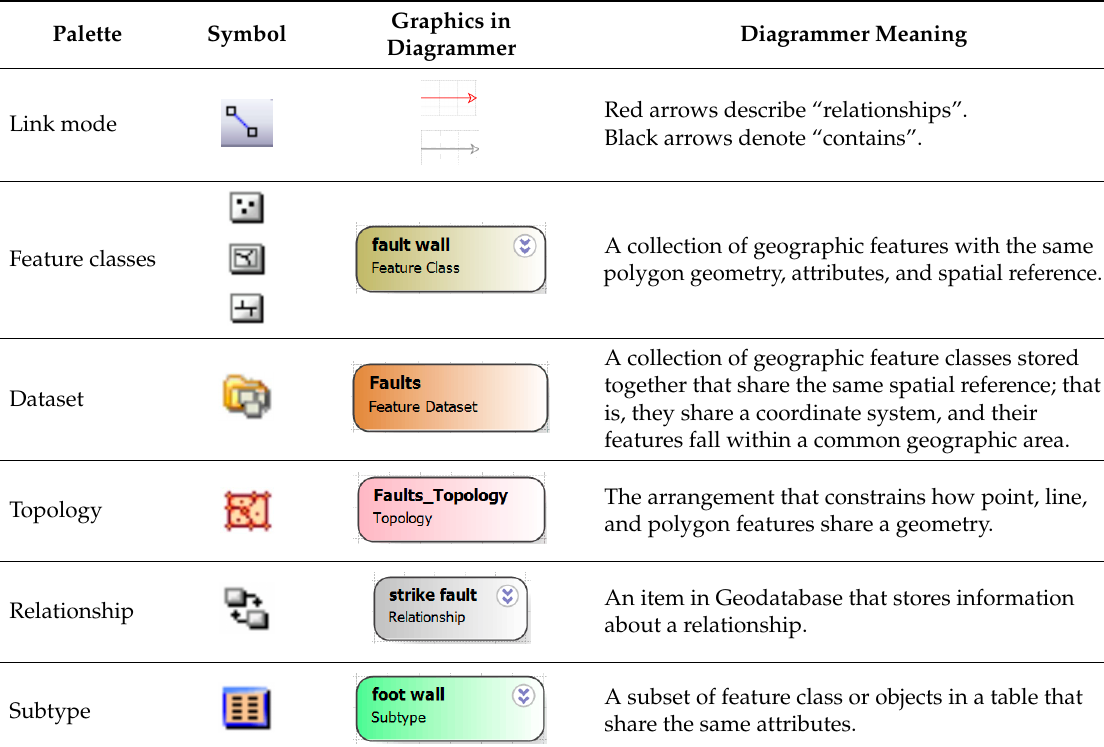
Table 3. Editable graphics in Diagrammer.